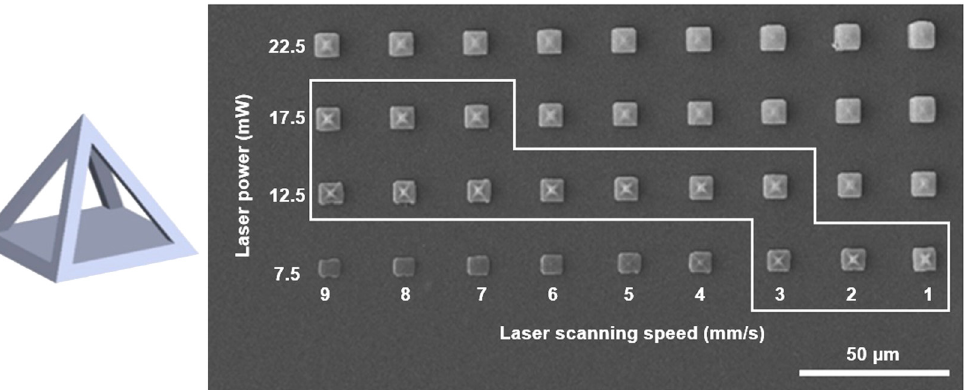
Figure 5: SEM images of a 4 × 9 array of pyramidal structures generated using AuNR/LCM photoresist with di ff erent sets of laser writing